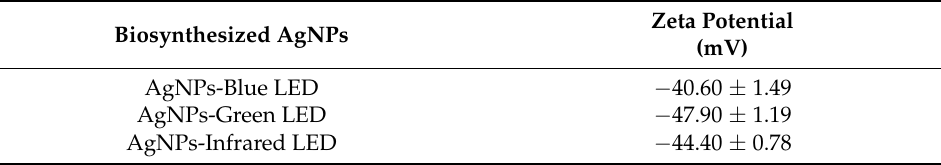
Figure 5. ( a – c ) Dynamic light scattering (DLS) analysis and ( d – f ) transmission electron microscopy (TEM) images of T. purpurogenus extracellular-pigment-mediated AgNP biosynthesis using blue (AgNPs-blue LED), green (AgNPs-green LED), and infrared (AgNPs-infrared LED) LEDs. Table 2. Zeta potential of LED-assisted biosynthesized AgNPs.